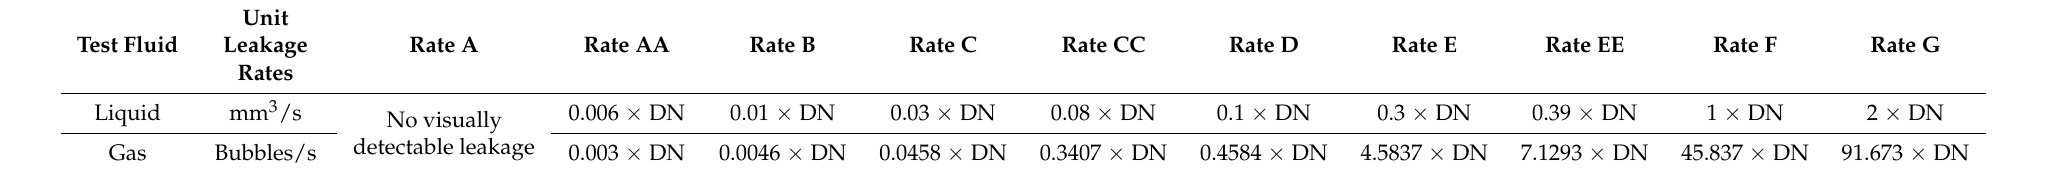
Table 1. Maximum allowable closure test leakage rate according to API 6D